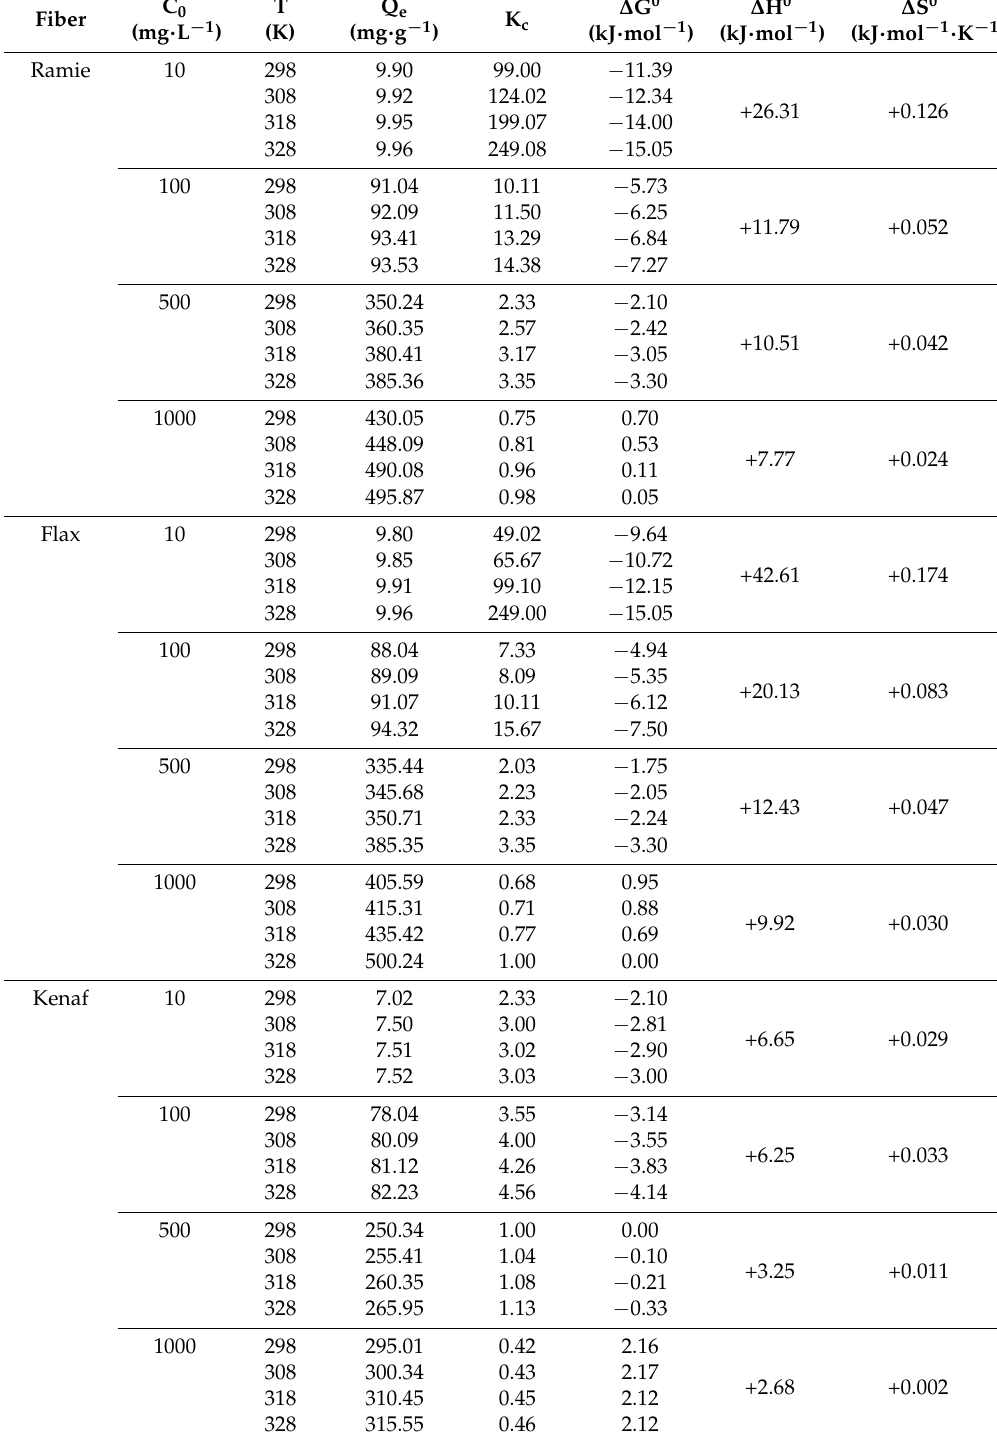
Table 3. Thermodynamic parameters for the adsorption of BY37 at 25, 35, 45, and 55 ◦ C onto ramie, flax, and kenaf